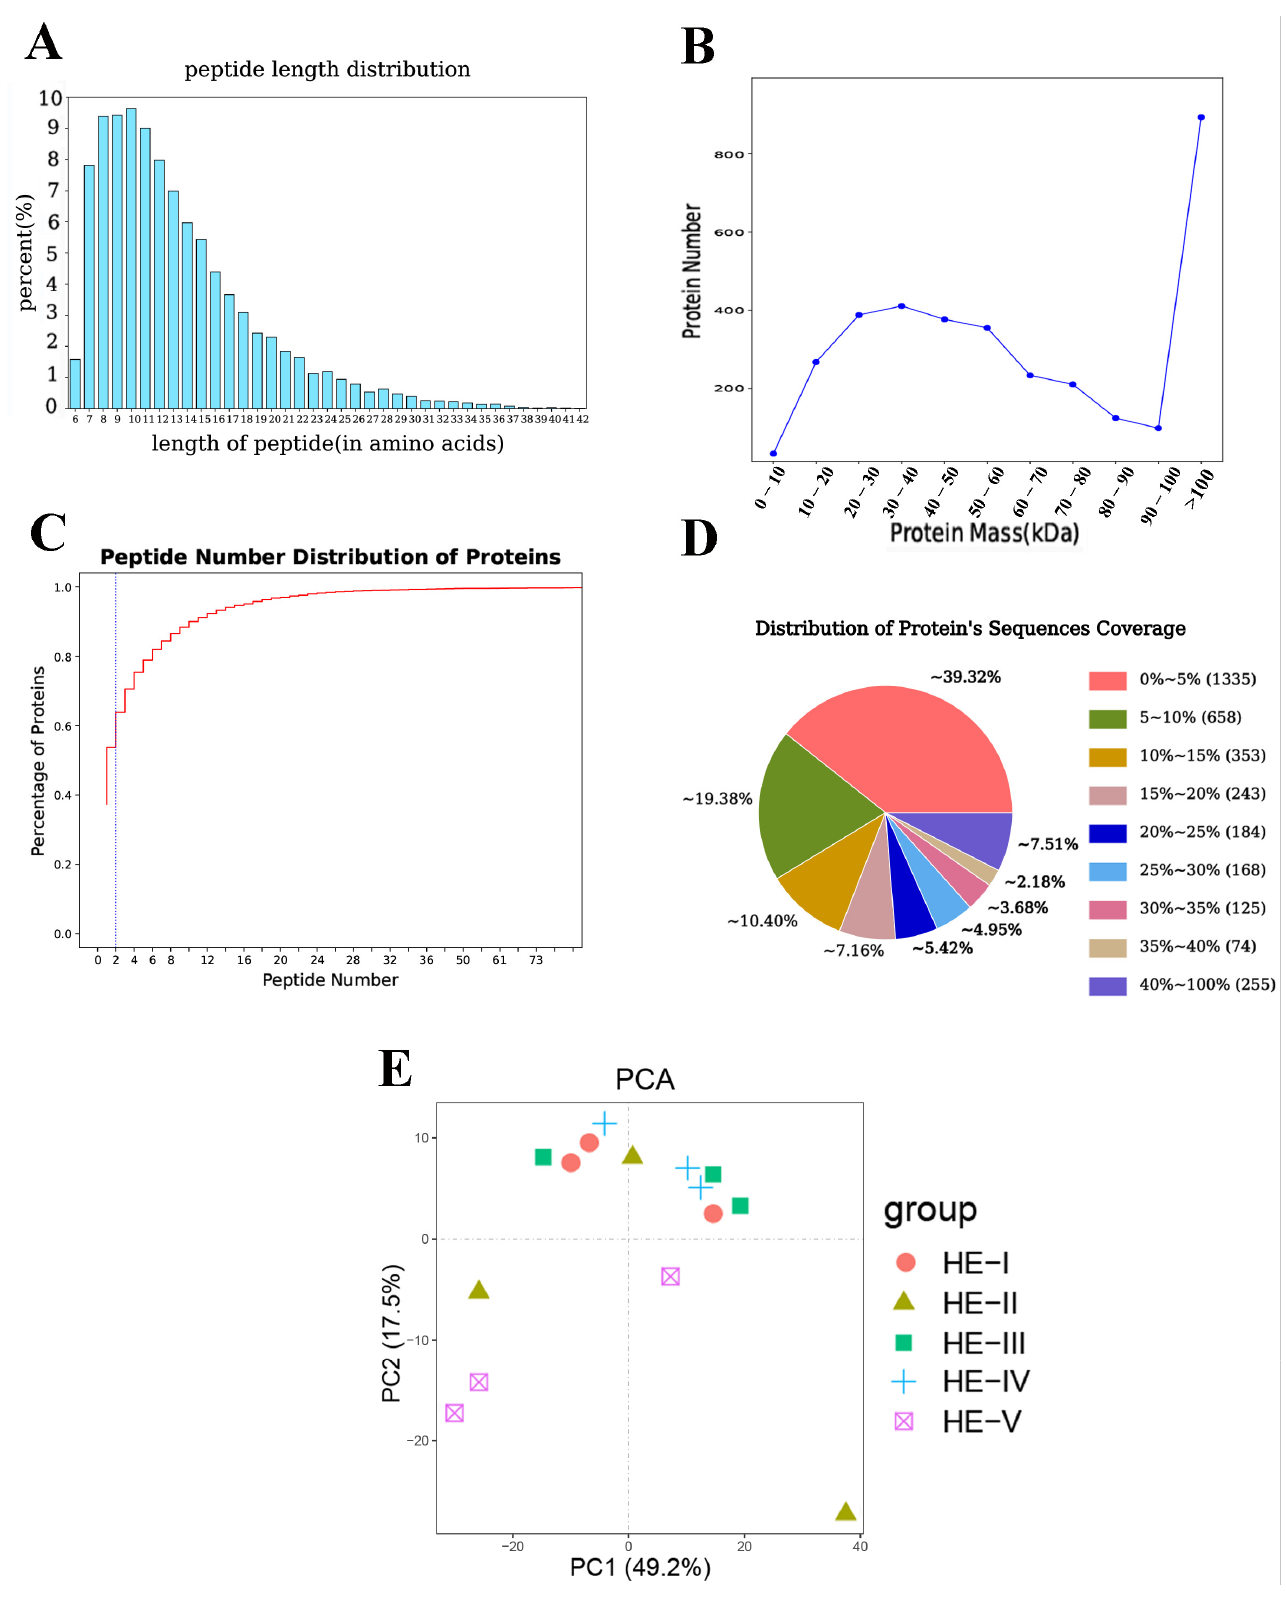
Figure 2. Summary information of hepatopancreas proteomes during ovary maturation of Macro- brachium nipponense. ( A ) The peptide length (amino acids). ( B ) Protein mass. ( C ) Spectrum percent of peptides. ( D ) Distribution of protein’s sequences coverage. ( E ) Proteins separation of PCA.